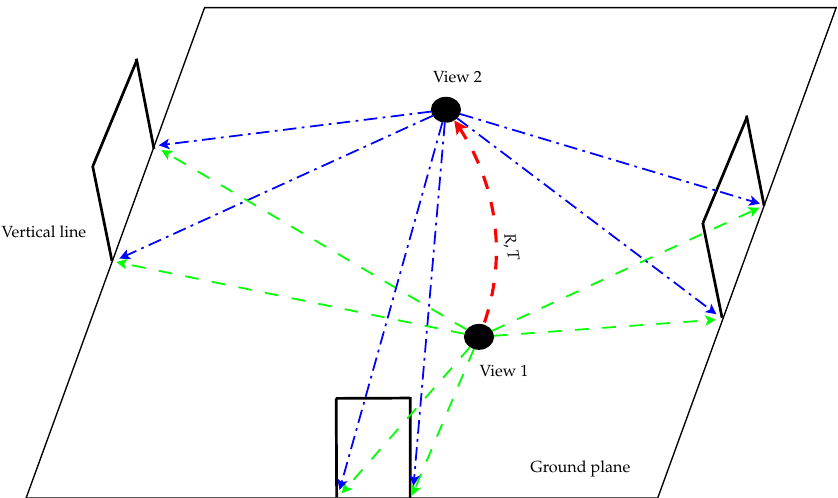
Figure 10. The mobile robot moves from the “View 1” position to the “View 2” with the same set of base points observed. It adopts a catadioptric camera to detect the vertical lines in this structured environment. The base points are used to estimate the 3D information for mobile robot localization.